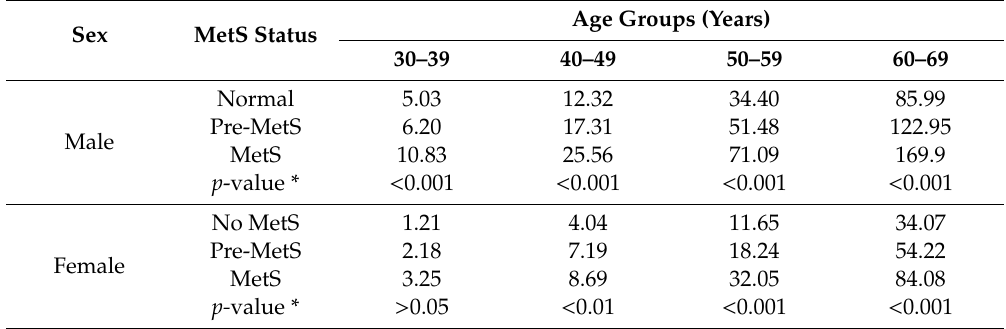
Table 2. Incidence rates (per 100,000 person-years) of atrial fibrillation according to sex, age group, and metabolic syndrome status.